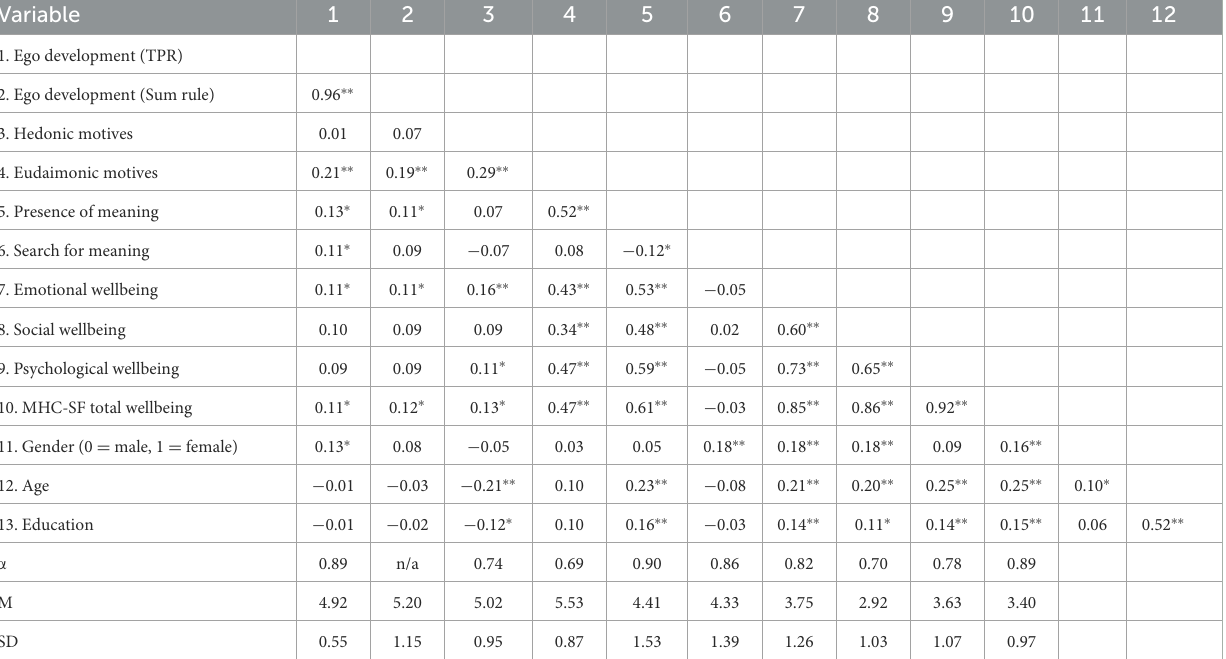
TABLE 2 Descriptive statistics and correlations for the study measures. Variable